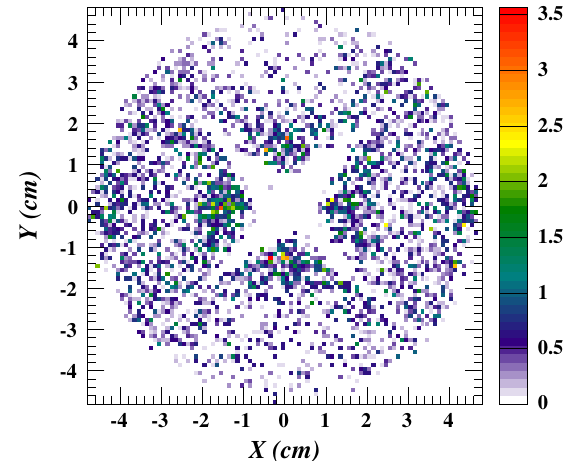
FIG. 9. The modeled transverse distribution of the trapped cloud shown at the end of the first beam revolution. The color scale ranges up to a maximum of 3 . 5 × 10 6 electrons =